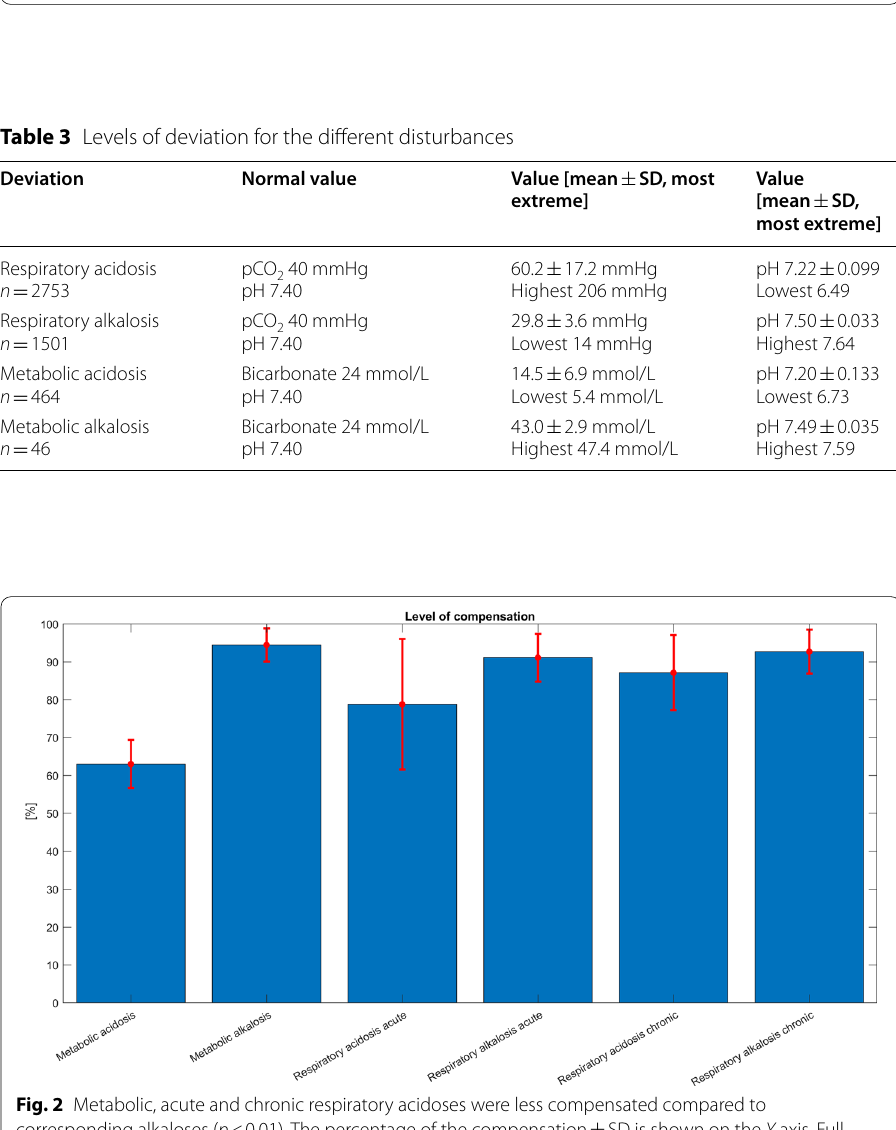
SD is shown on the Y axis. Full ±